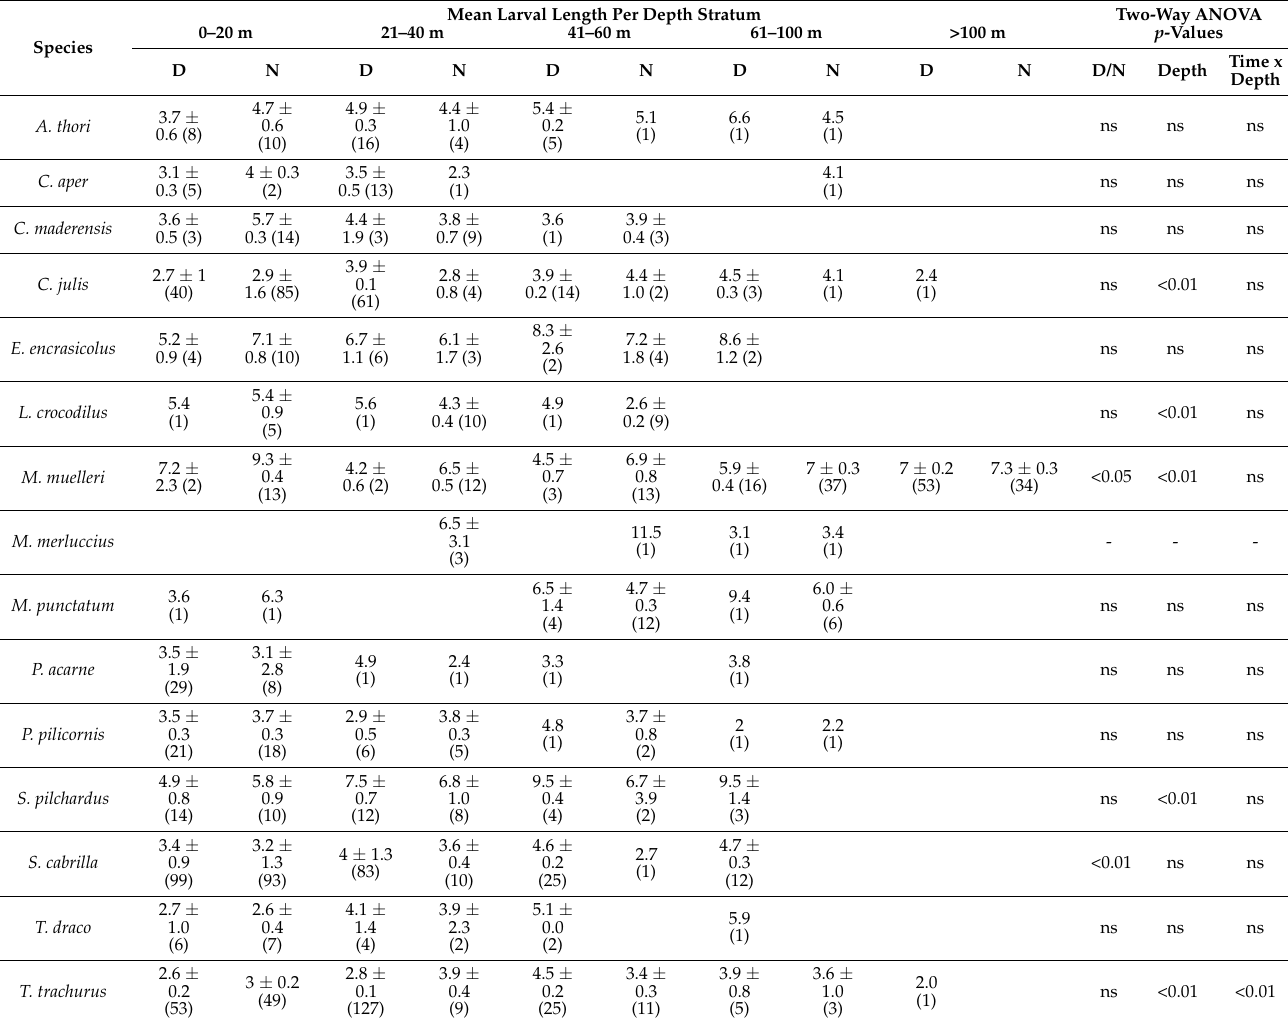
Table 6. Mean ( ± standard error) of larval length (mm) and number of individuals per depth stratum and time (D: day, N: night). The results of the two-factor ANOVA for differences in the larval length of the most abundant taxa between time and depth are also shown. Legend: ns not significant.